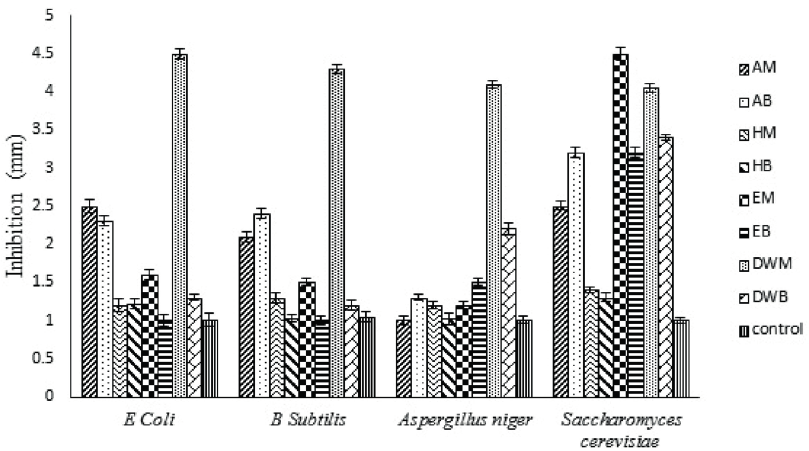
Figure 2 - Inhibition zone (mm) produced by different betel leaf extracts against various pathogens. Where, AM- Acetone Meetha , AB- Acetone Banarasi , HM- Hexane Meetha , HB- Hexane Banarasi , EM- Ethanol Meetha , EB- Ethanol Banarasi , DWM- Distilled Water Meetha , DWB- Distilled Water